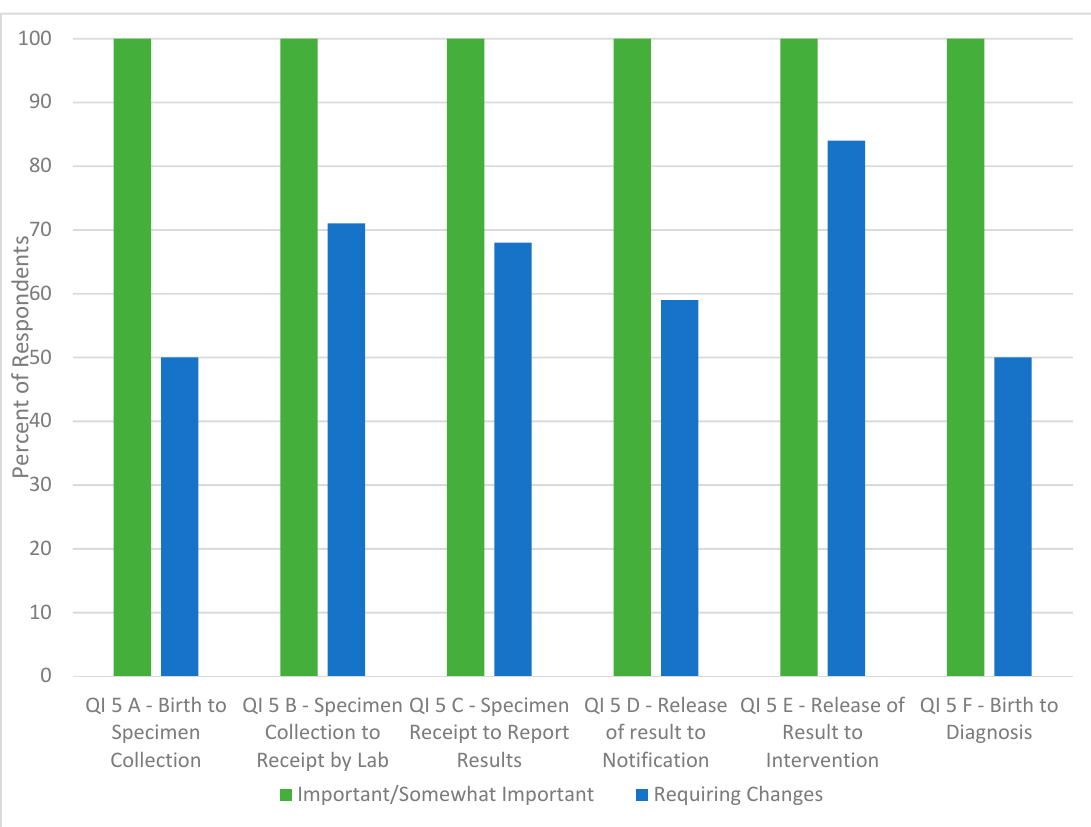
Table 4. National Newborn Screening Quality Indicators (Final as of